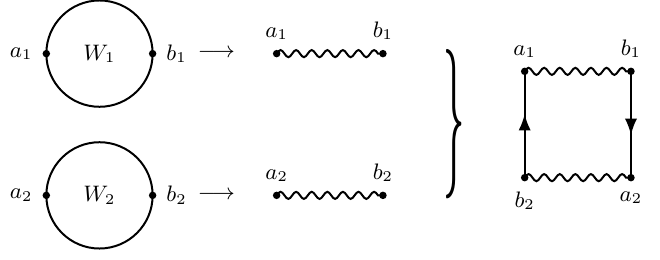
Figure 1 . Gluing two cycles W 1 and W 2 into a single one. A directed edge from node i to j represents a factor of 1 while a wavy edge is de(cid:12)ned by eq. (2.3). z ij s := P s . The de(cid:12)nition (2.5) is clearly cyclic, and the factor 1 ij W i<j 2 W